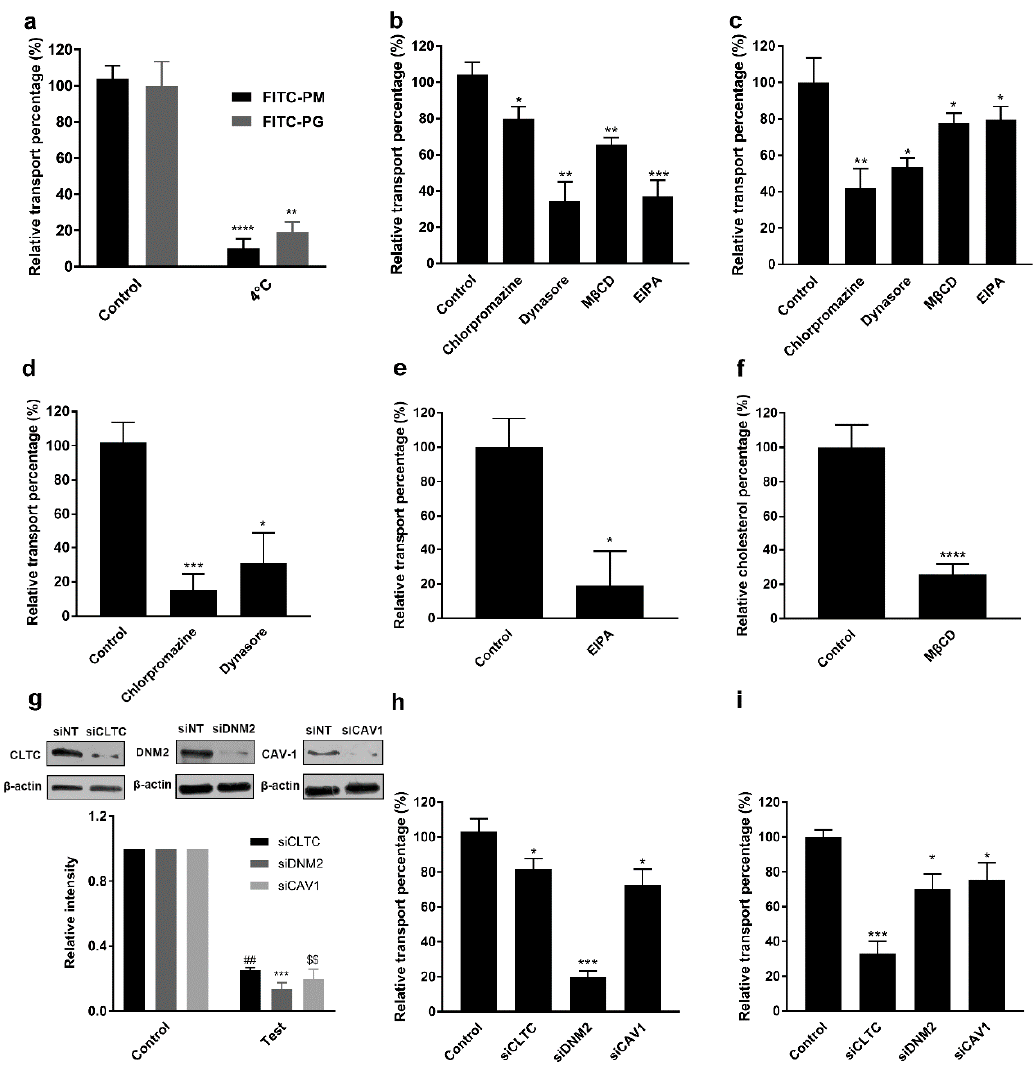
Figure 5. Effect of transport inhibitors and gene silencing on uptake of F-PM and F-PG into Caco-2 cells. ( a ) Effect of low temperature on the transport of F-PM and F-PG; ( b ) effect of transport inhibitors on F-PM transport; ( c ) effects of transport inhibitors on F-PG transport; ( d ) effects of chlorpromazine and dynasore on transferrin transport; the regression equation of FITC-transferrin was y = 952458 x + 91,356 (R 2 = 0.9990, in the range of 0.001–6.25 μ g/mL); ( e ) effect of EIPA on glucan transport; the regression equation of FITC- glucan was y = 512,495 x + 35,382 (R 2 = 0.9999, in the range of 0.01–12.5 μ g/mL); ( f ) effect of M β CD on total cholesterol in Caco-2 cells; ( g ) effect of siRNA silencing CLTC, DNM2, and CAV1. The values were normalized to a non-targeting siRNA (siNT) control; ( h ) the effect of gene silencing on F-PM transport; ( i ) the effect of gene silencing on F-PG transport. * p < 0.05; ** p < 0.01; *** p < 0.001; **** p < 0.0001; ## p < 0.01; $$ p < 0.01.